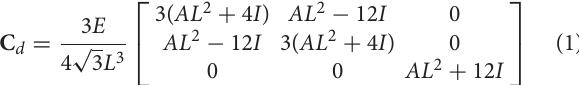
that isotropic constitutive relations are found by means of the multiscale